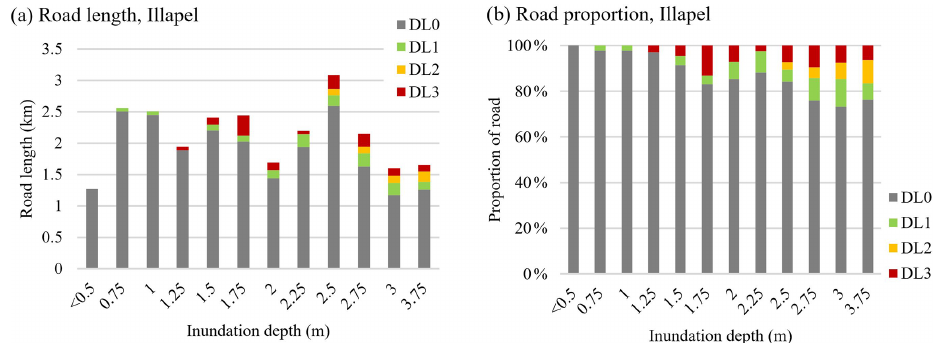
Figure 3. Total length (a) and proportion (b) of exposed roads, by inundation depth, for the 2015 Illapel earthquake and